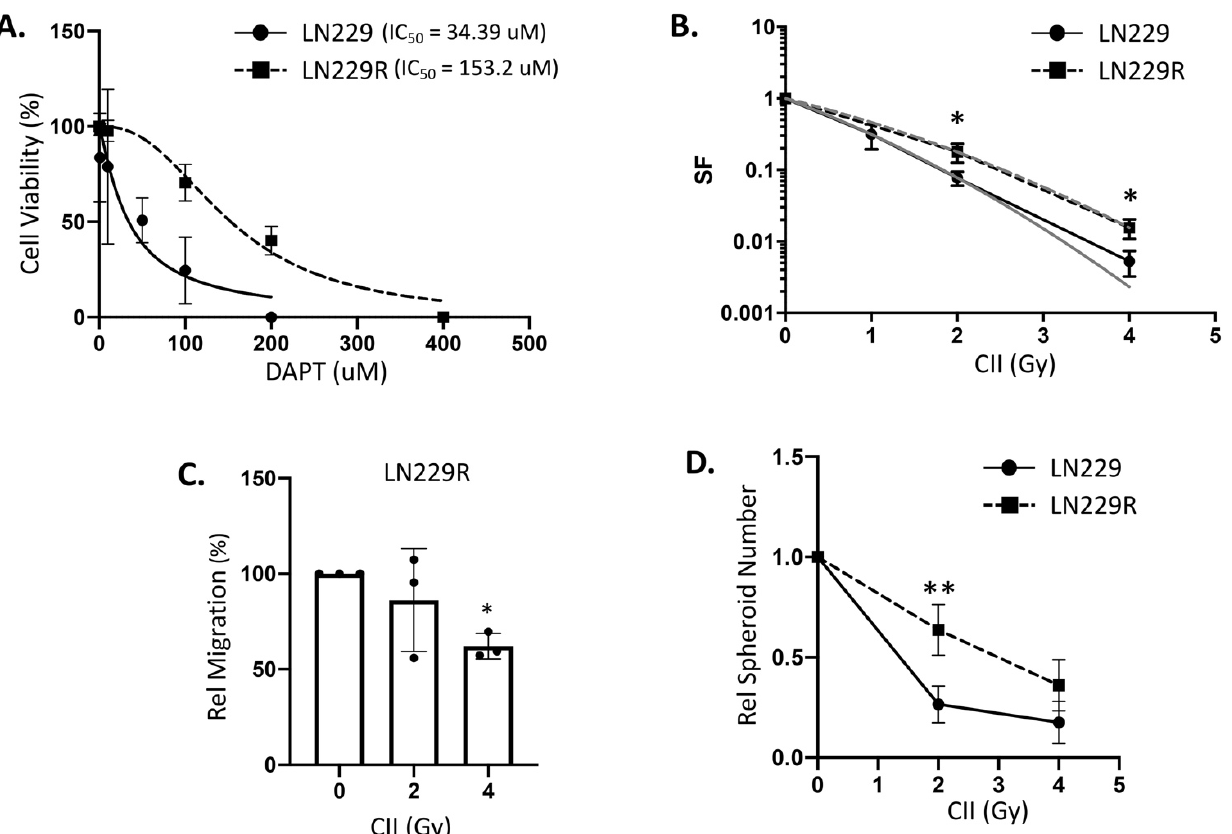
Figure 7. Notch inhibitor (DAPT) resistant glioma cell line (LN229R) is less responsive to CII-mediated effects: ( A ) Cell viability of parental LN229 vs. DAPT resistant LN229R cell lines as measured by Cell Titre Lumi after 72 h incubation in different concentration of DAPT; ( B ) Clonogenic survival curve of LN229 (solid black line) and LN229R (dashed black line) glioma cell lines exposed to different doses of CII, the grey line represents the linear quadratic (LQ) fitted survival curve; ( C ) Relative migration of LN229R cell line at 24 h exposed to different doses of CII. Each symbol represents one independent experiment. Each experiment was performed in duplicate; ( D ) Relative spheroid number of LN229R glioma cell line at day 10–14 after irradiation with CII. Each experiment was performed in triplicate. Data are from 3–4 independent experiments and presented as mean ± SD. Statistical analysis was performed by ANOVA with Bonferroni post-hoc test. p -values (* p < 0.05, ** p < 0.01).